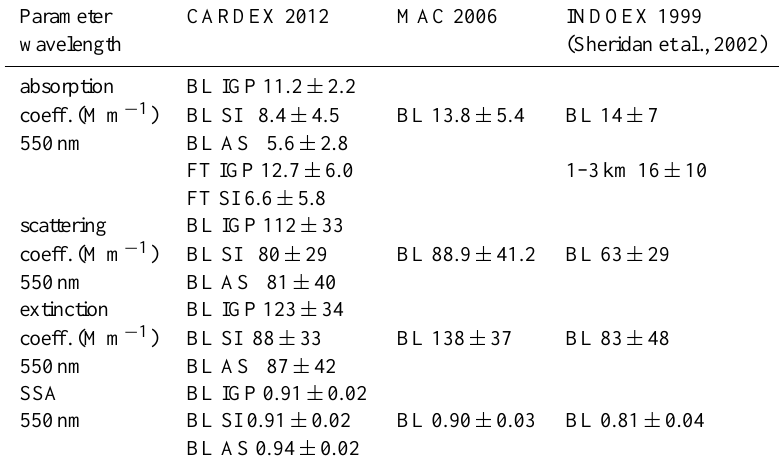
Figure 5. (a) Vertical profile of the median PM 1 particle number concentration during CARDEX (blue), MAC (black dashed) and INDOEX (black solid) with 25 and 75% percentiles, measured by a CPC onboard the AUAV. (b) and (c) Median PM 10 particle number concentration during CARDEX with 25 and 75% percentiles in the FT and MBL, respectively for air masses originating from the Indo-Gangetic Plain, southern India and Arabian sea (blue, green, red). Table 2. Mean particle properties during CARDEX at the surface and in some cases above the MBL at dry conditions (RH < 40%) compared to MAC 2006 and INDOEX 1999. Particle properties for CARDEX are given for the different source regions, Indo-Gangetic Plain (IGP), southern India (SI) and Arabian Sea (AS), for BL and